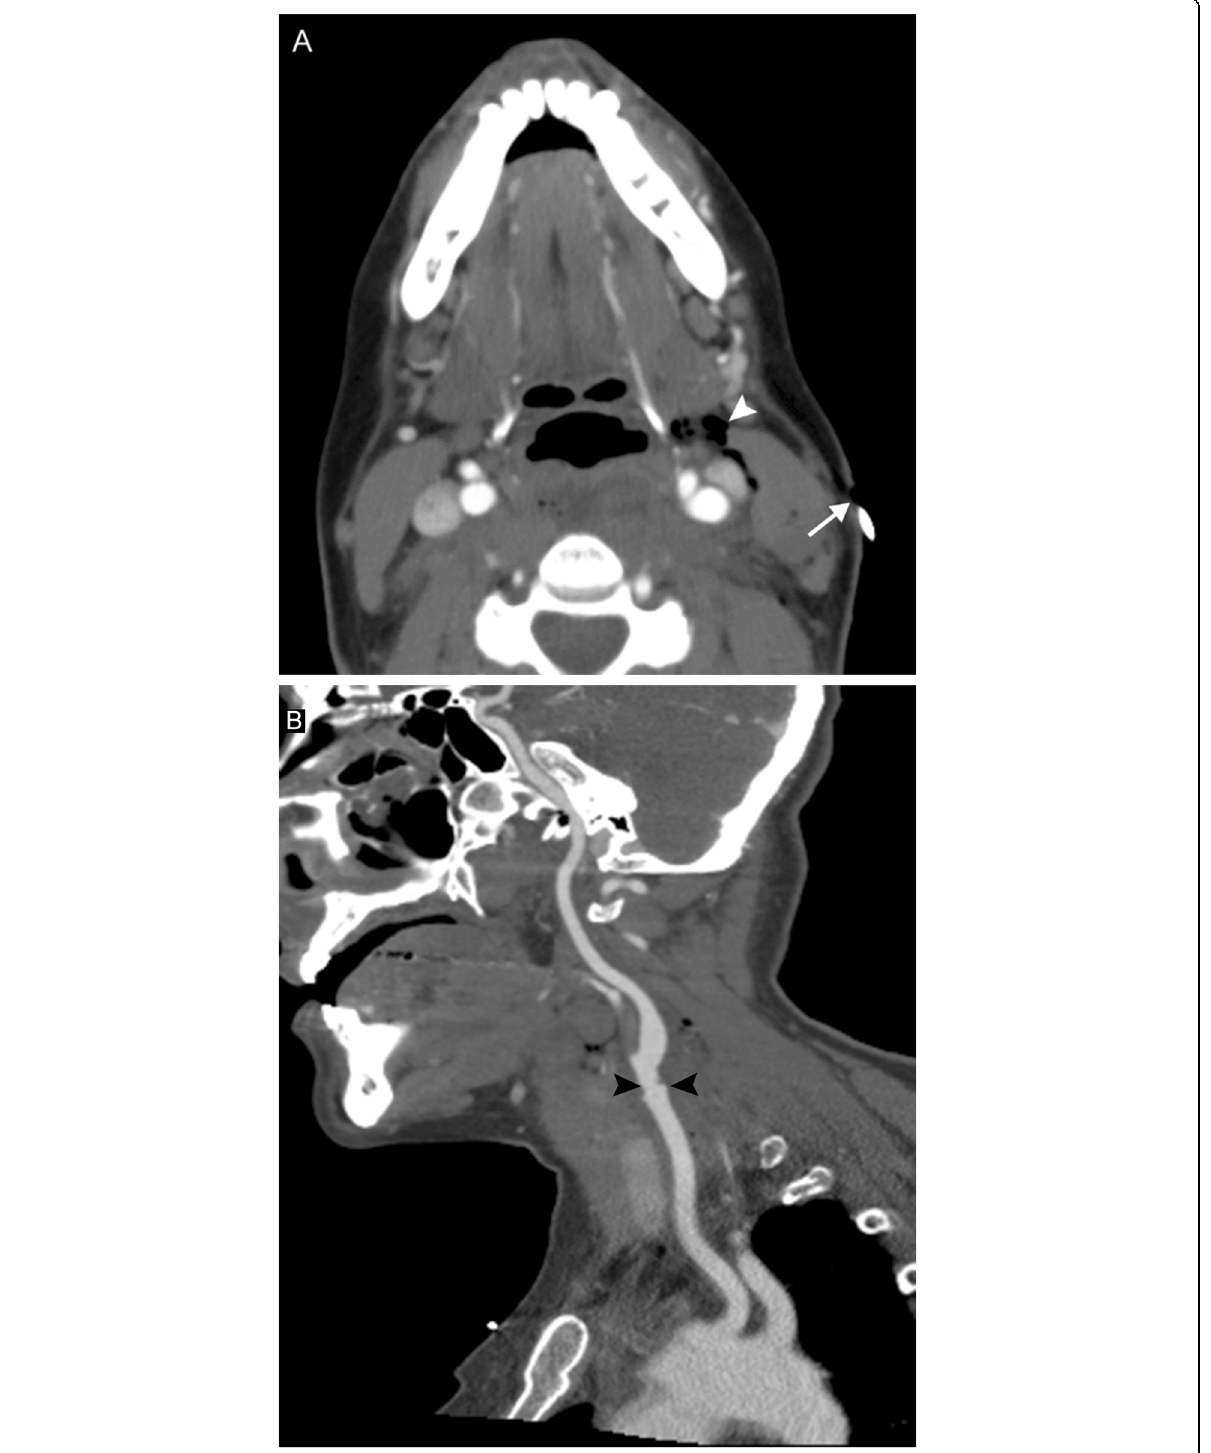
Fig. 24 Carotid space trauma. A 33-year-old woman who sustained a stab wound to the neck, subsequently noted to have a weak voice; laryngoscopy confirmed vocal cord paralysis. Axial CTA of the neck ( a ) reveals a radiopaque marker at the entry site (white arrow); air is seen within the deep soft tissues anterior to the left carotid sheath contents (white arrowhead), indicating violation of the left carotid space. 3D- volume-rendered CTA image ( b ) of the left carotid artery shows irregular caliber and focal outpouching of the distal left common carotid artery (black arrowheads), representing pseudoaneurysm. Findings are consistent with left vocal cord paralysis due to vagal nerve